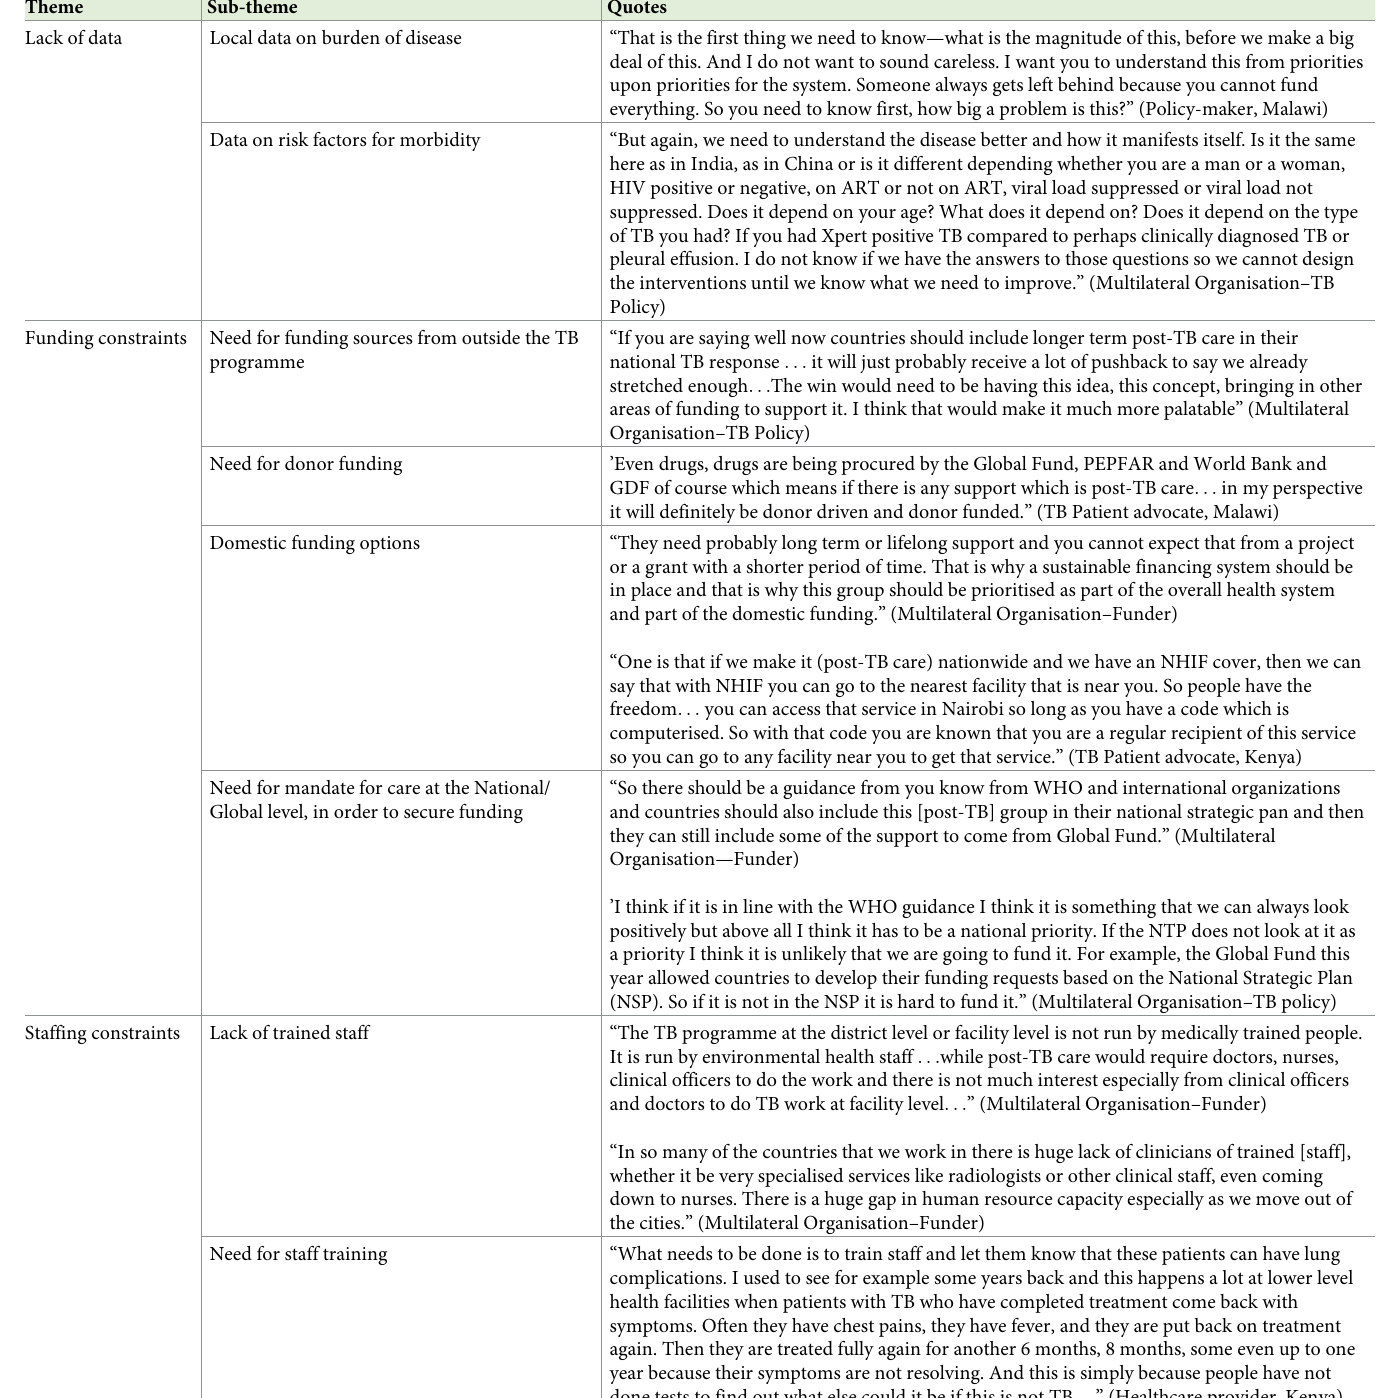
Table 4. Direct participant quotes: Barriers to implementation of post-TB